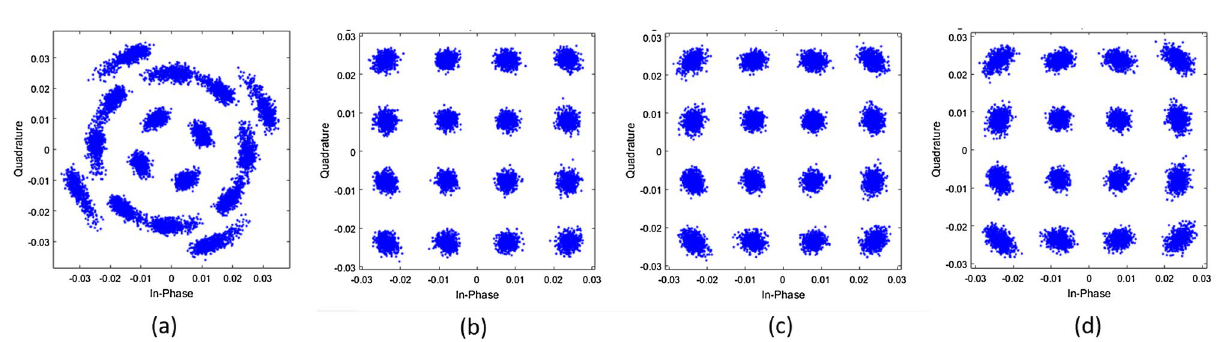
x -polarisation before and after 1 state MKF at ˆ